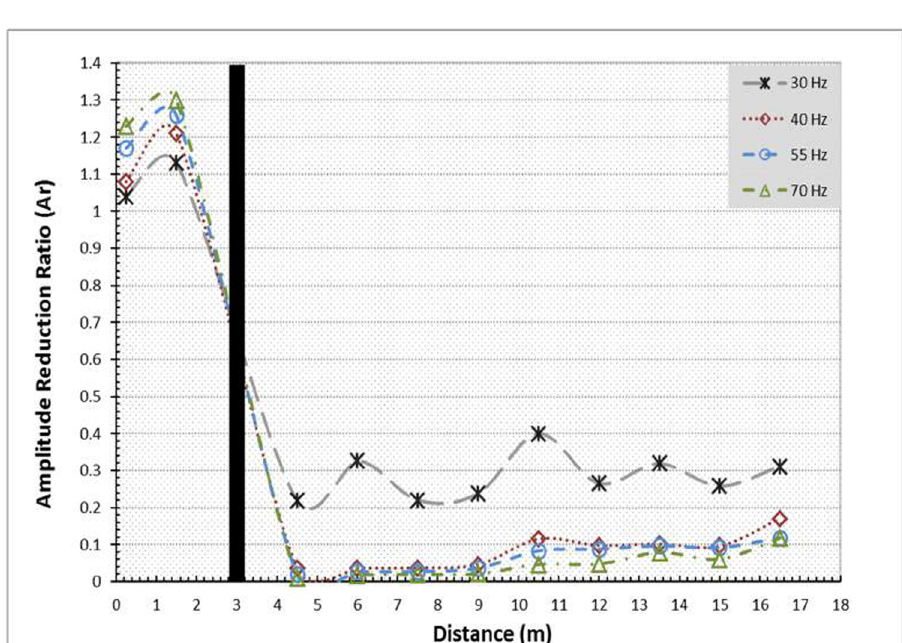
Figure 9: Attenuation of vibration velocity due to an open trench barrier ( active screening )